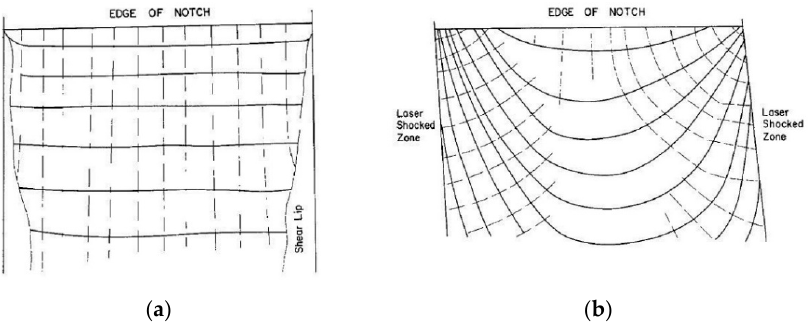
Figure 13. Maps of the crack front progression from the tip of the notch in the side of a hole in 2024-T3: ( a ) not shocked; ( b ) shocked both sides simultaneously with a split beam [33].